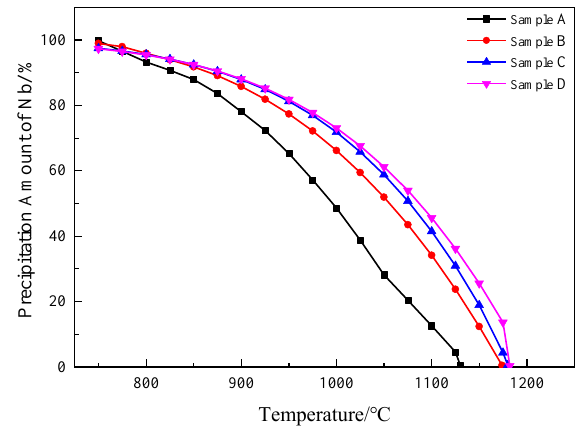
Figure 11. The relationship between the precipitation of Nb and the temperature.